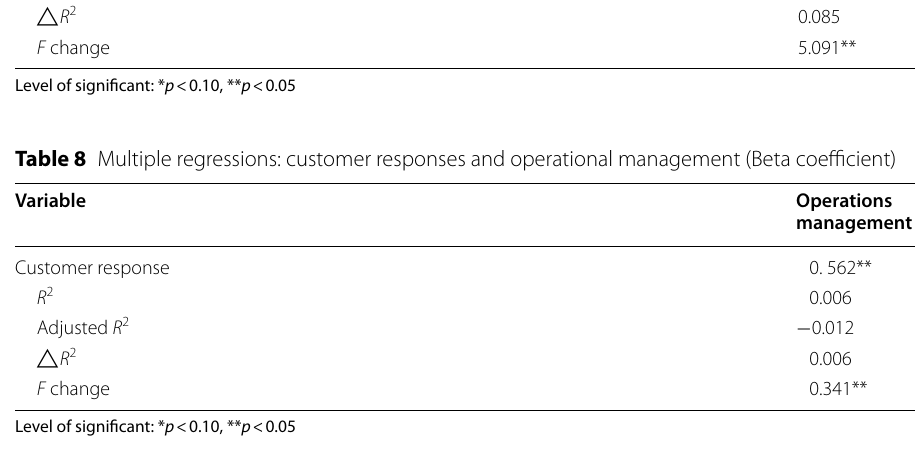
Table 9 Multiple regressions: operations management and financial management (Beta coefficient)